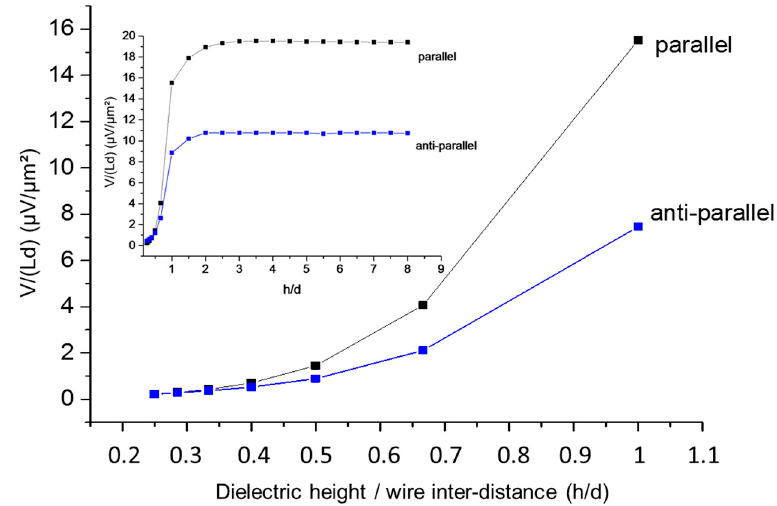
Figure 12. Surface potential as function of the parameter h/d for a two-wires in parallel and anti-parallel configurations under a bending with ρ = 10 cm curvature radius. The potential is taken at the top electrode while the bottom one is grounded (see Figure 8). The graph focuses on values of h/d lower than 1. The inset graph shows a zoom out for the whole range of values of h/d from 0.25 to 8.